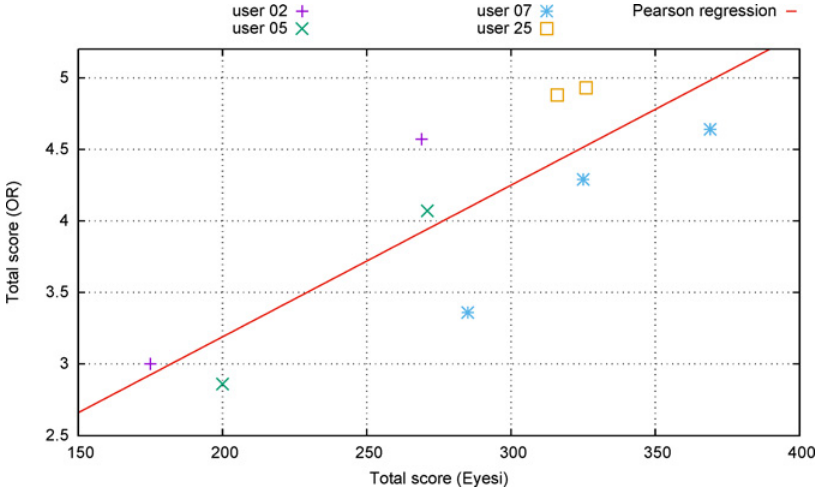
Fig 2. Comparison of the Eyesi score and the total score in the operating room. Individual surgeons are marked by different symbols. The experience of each surgeon in years is shown as part of his user name. The linear fit was determined by using a Pearson regression.